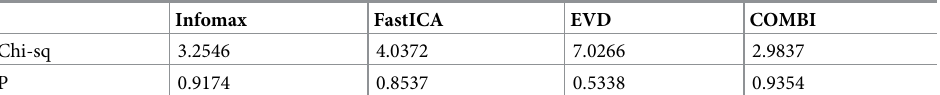
For each non-deterministic algorithm, ICASSO was run k times ( k = 10, 20, 30, 40, 50, 60, 70, 80, 90, 100) to acquire 10 results. The most reliable ICASSO results (shown in Table 4 for the motor data) and the other results were compared by using the Kruskal–Wallis test.